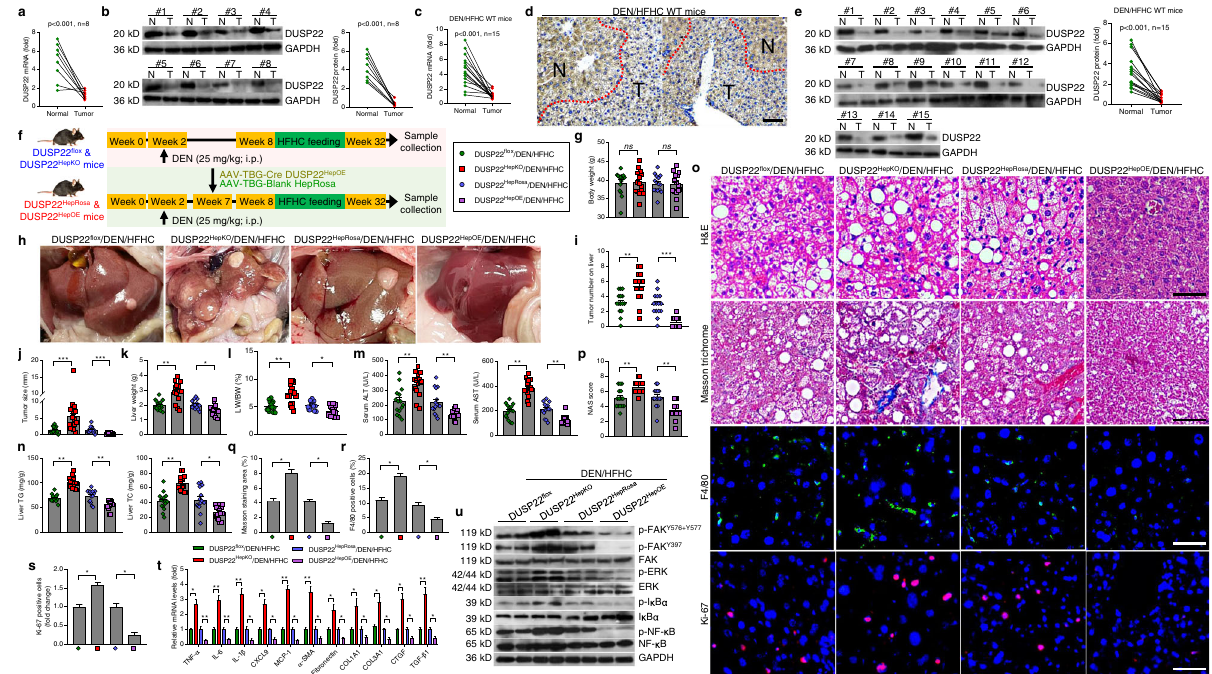
m serum concentrations of ALT and AST, and n liver TG and TC levels from the indicated groups of mice ( n =15 mice per group) (* P <0.05 and ** P <0.01). o Representative images of H&E staining (Scale bars, 50 µ m), Masson trichrome staining (Scale bars, 50 µ m), immuno fl uorescence examination of F4/80 (Scale bars, 20 µ m)and Ki-67 (Scale bars, 20 µ m) in liversections from the shown groups of mice ( n =6 or 15 mice per group, with 10 images for each mouse). p – s Measurements of p NAS score, q Massontrichrome-positive staining, r F4/80- positive cells, and s Ki-67-positive cells were analyzed and quanti fi ed ( n =6 or 15 mice per group) (* P <0.05 and ** P <0.01). t RT-qPCR results for mRNA levels of in fl ammation- and fi brosis-related genes as shown in liver of the indicated groups of mice ( n =8 mice per group) (* P <0.05 and ** P <0.01). u Representative western blotting and quanti fi cation of the protein expression of total and